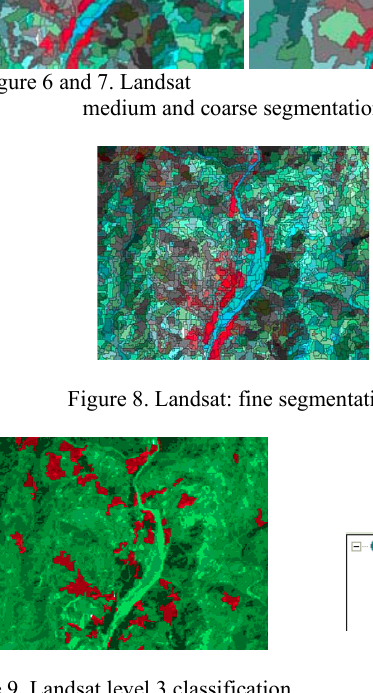
Figure 9. Landsat level 3 classification In order to produce highly homogeneous objects in specific resolutions and for specific purposes, segmentation parameters were empirically determined, by adjusting and editing the scale parameters, band weights, shape, and color. The burned areas are more visible in bands 3 and 4 than in bands 1 and 2, so to bands 1 and 2 a “1” was assigned. All weights have a sum normalized to 1.